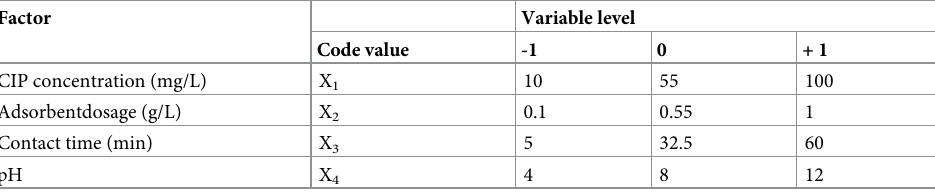
Table 1. Range and levels of independent variables used in design of